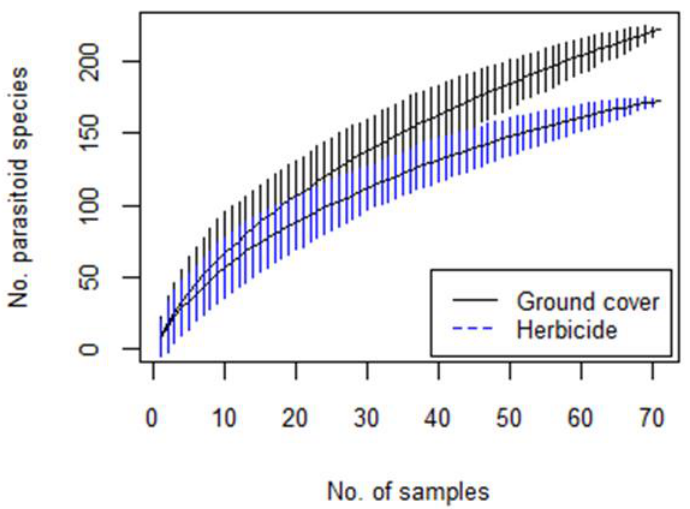
Figure 4. The cumulative number of parasitoid species in the ground cover and herbicide plots, with associated 95% confidence intervals.